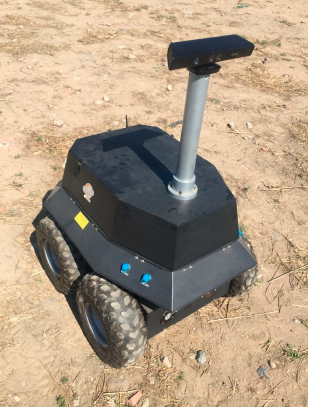
Figure 5. The RGB-D camera mounted on the moving platform.